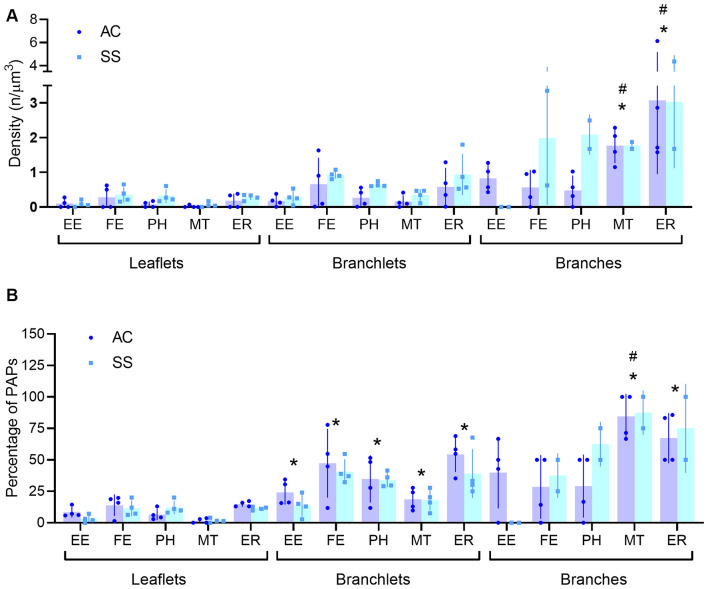
(A,B) Quantification of PAP subcellular organelle distribution (A) and percentage of perisynaptic astrocytic processes (PAPS) displaying at least one organelle (B). All data are segregated for leaflets, branchlets, and branches (n = 4). Empty endosomes (EE), full endosomes (FE), phagosome (PH), mitochondria (MT), and ER cisternae (ER) for all panels. *Indicates significant pairwise comparisons (mixed-effects analysis, p < 0.05, Bonferroni corrected) relative to leaflets, whereas, the #indicates significant pairwise comparisons (mixed-effects analysis, p < 0.05, Bonferroni corrected) relative to branchlets.